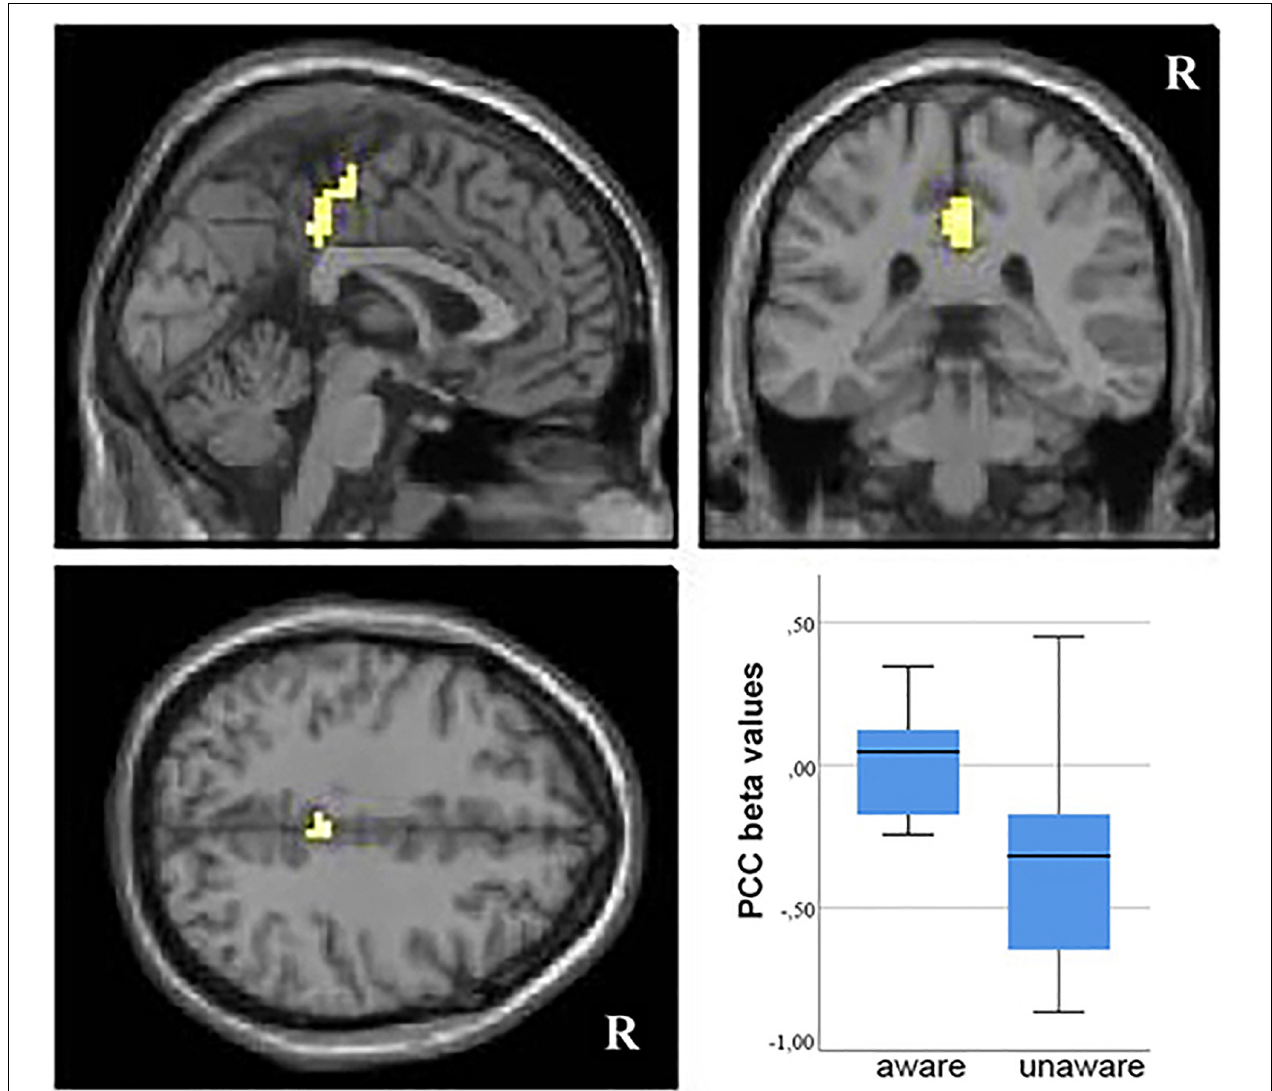
FIGURE 2 | Group analysis fMRI results. Areas of increased differential signal in response to dementia-related vs. negative words in the comparison between aware vs. unaware patients (voxel-wise p < 0.001 and cluster size ≥ 47 voxels, as determined by 3dClustSim AFNI routine). R, right. Resulting clusters are superimposed on the MNI template implemented in SPM8. On the right, box plot of mean beta values extracted from the posterior cingulate cortex (PCC) region of interest in aware and unaware